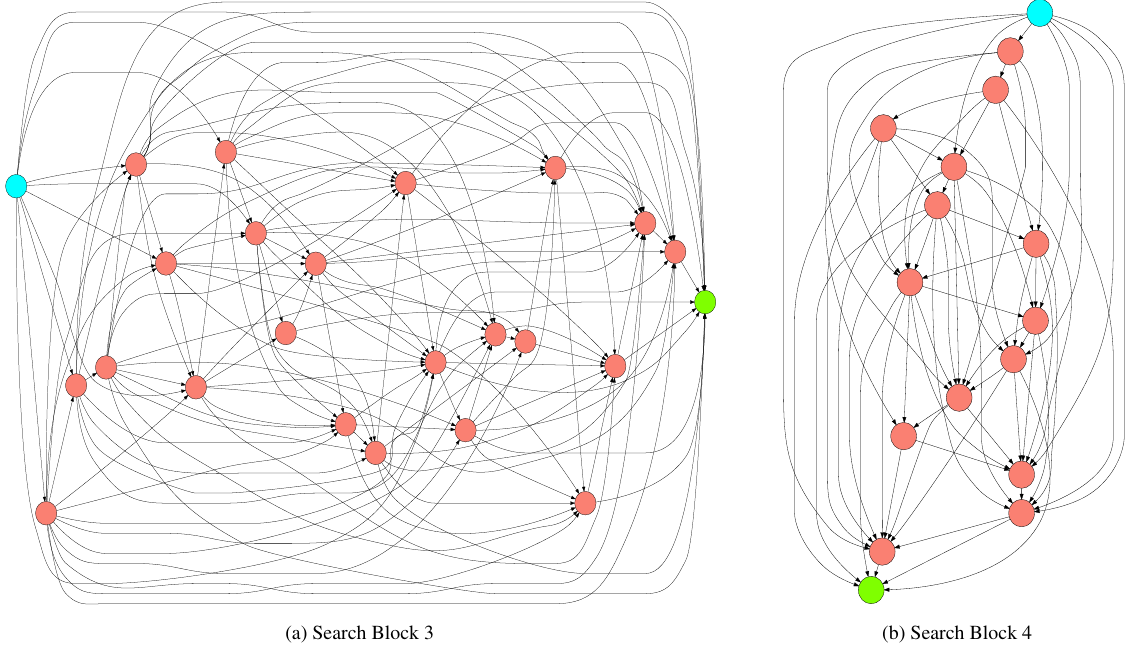
Figure 3. Visualization results of Search Block 3 and Search Block 4 in PDN moel. Cyan, salmon and chartreuse represent input node, middle node and output node respectively. The closer a node is to the output node, the more connections a node may own. Topological connections are all determined by machine